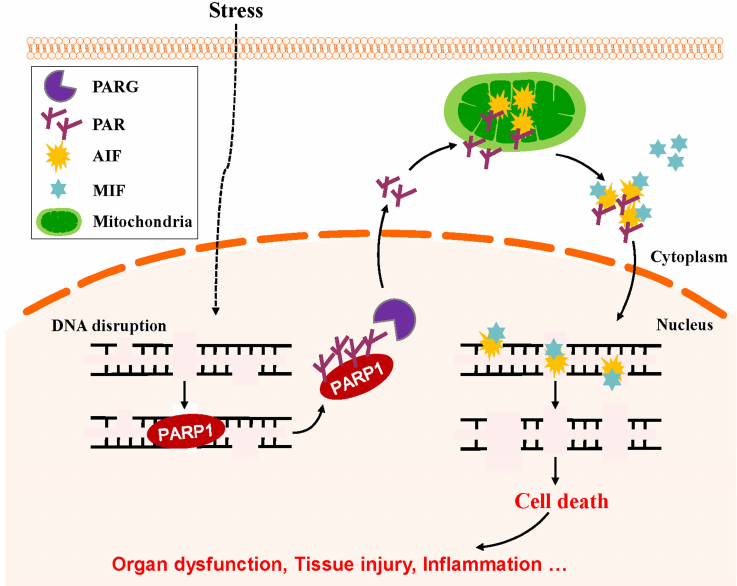
Figure 6. PARP1-mediated parthanatos by triggering AIF release from mitochondria. DNA damage in cell-stress conditions leads to PARP1 activation. PAR generated by PARP1 is hydrolyzed by PARG into free PAR and is translocated to the mitochondria, which induces AIF release from the mitochondria, translocation to the nucleus, and induction of the cell